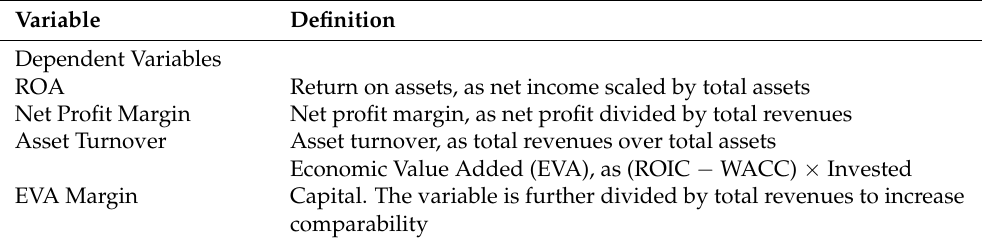
Table 1. Variables